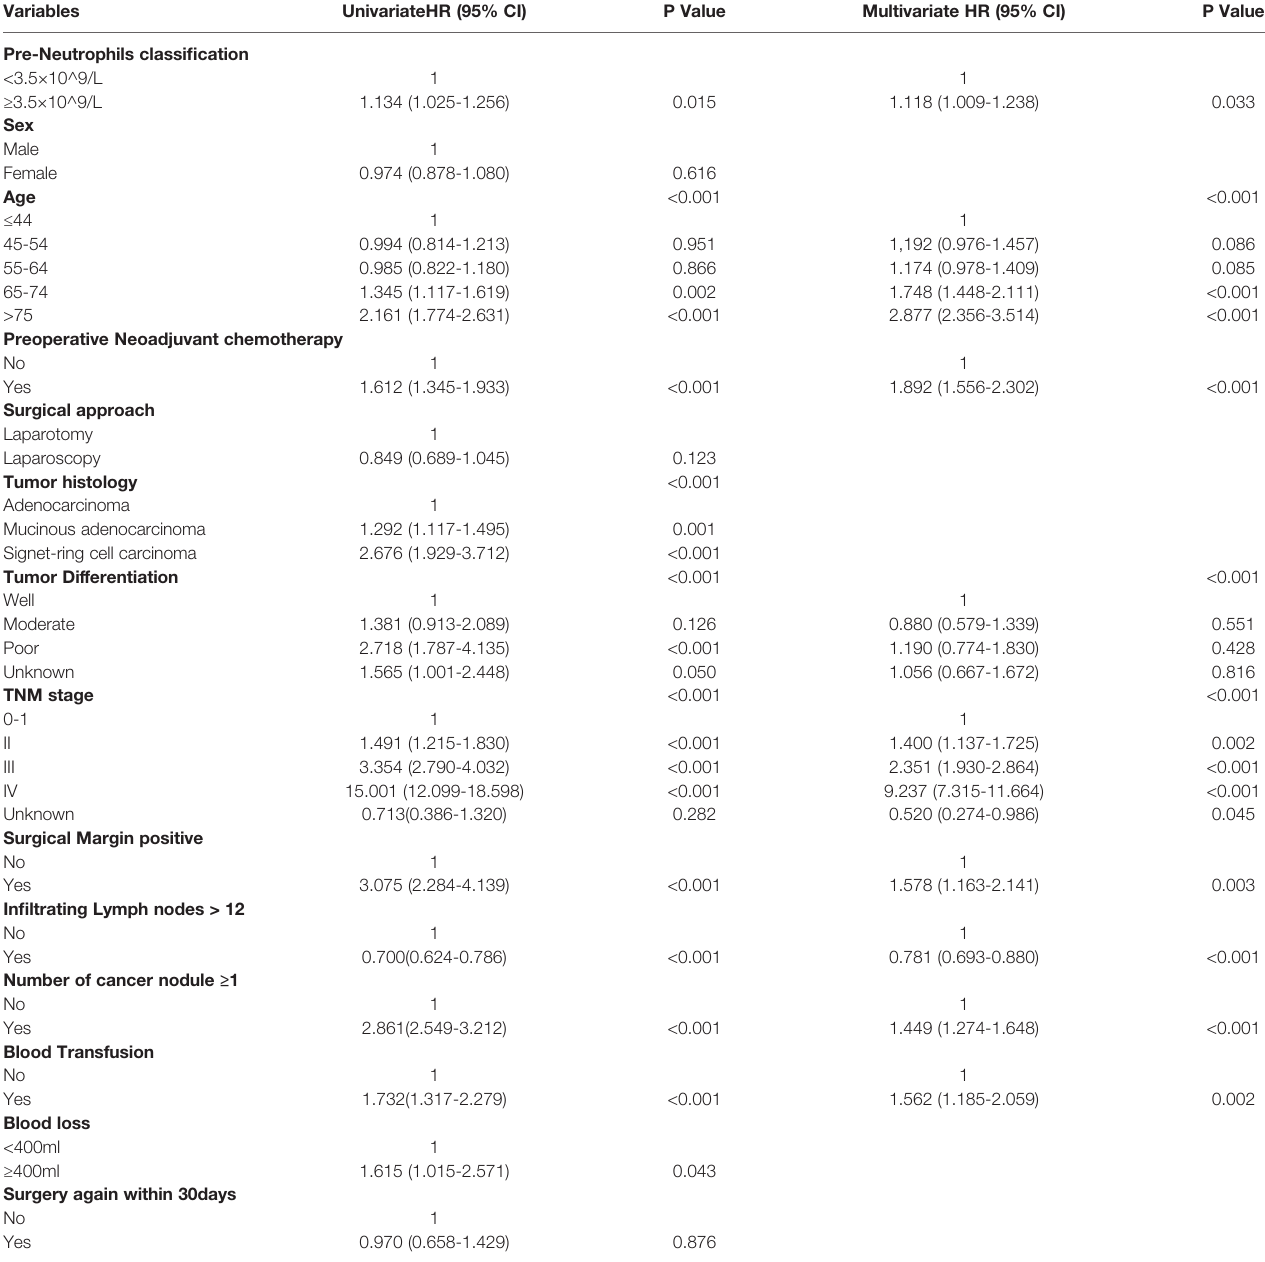
TABLE 8 | Univariate and multivariate Cox regression analysis for DFS in the propensity-matched